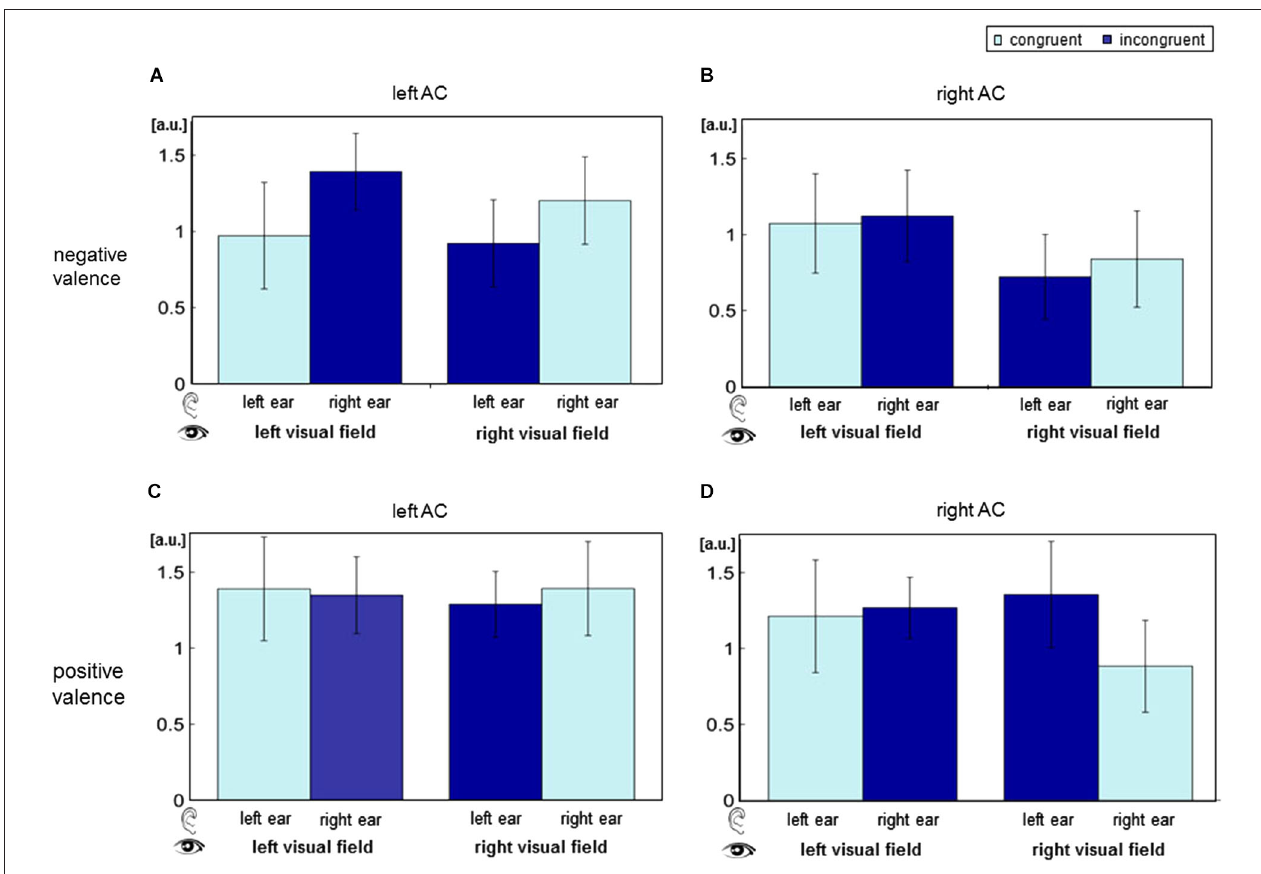
visual stimuli had negative valence; in the lower row ( C and D ), valence was positive. ANOVA revealed significant main effect of visual field and an interaction of valence and visual field. a.u.: arbitrary units; AC: auditory